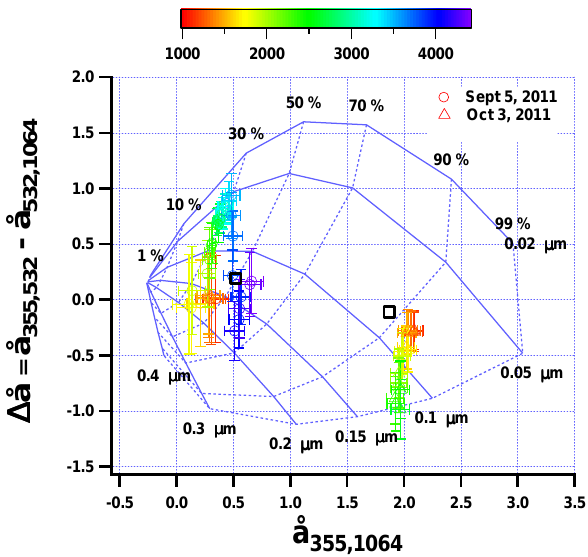
Fig. 9. 1 å (z) vs. å 355 , 1064 (z) scatter plot with corresponding uncertainties retrieved from lidar measurements performed on 5 September 2011 from 14:14 to 14:45UTC (open dots) and on 3 6 October 2011 from 12:41 to 13:16UTC (open triangles). The open black boxes represent the 1 å in and å in (355, 1064) data points re- ferring to 5 September and 3 October 2011,